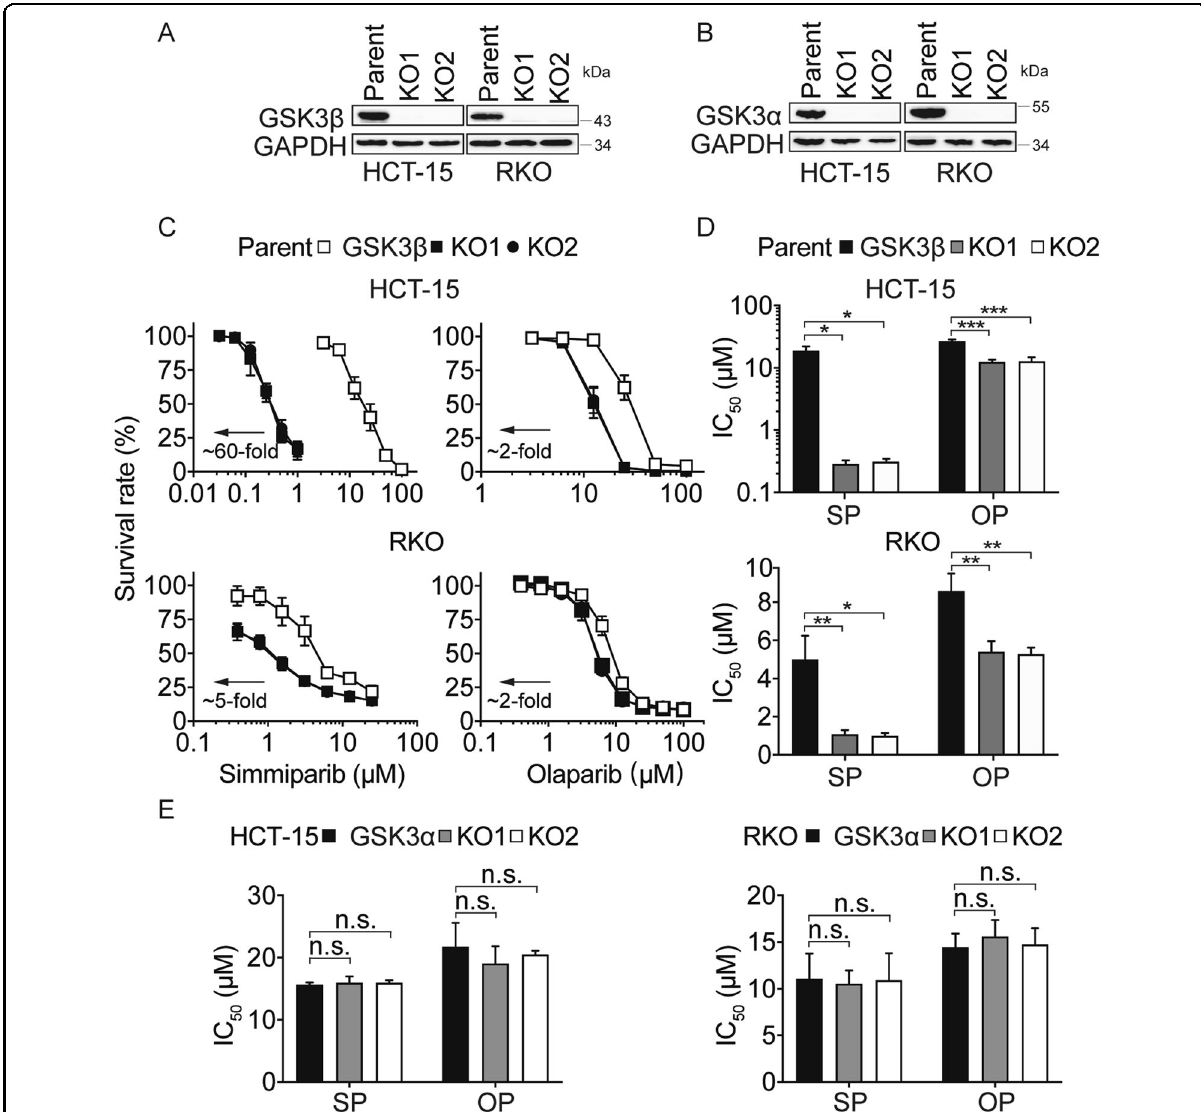
Fig. 3 GSK3 β depletion selectively sensitizes cancer cells to PARPi. A and B Levels of GSK3 β and GSK3 α protein in different GSK3 β − / − or GSK3 α − / − clonal variants (KO1 and KO2) of HCT-15 and RKO (parent) cells were detected using western blotting. C – E The change in sensitivity to PARPi following GSK3 β ( C and D ) or GSK3 α depletion ( E ). Cells were treated with simmiparib (SP) and olaparib (OP) for 7 days then subjected to